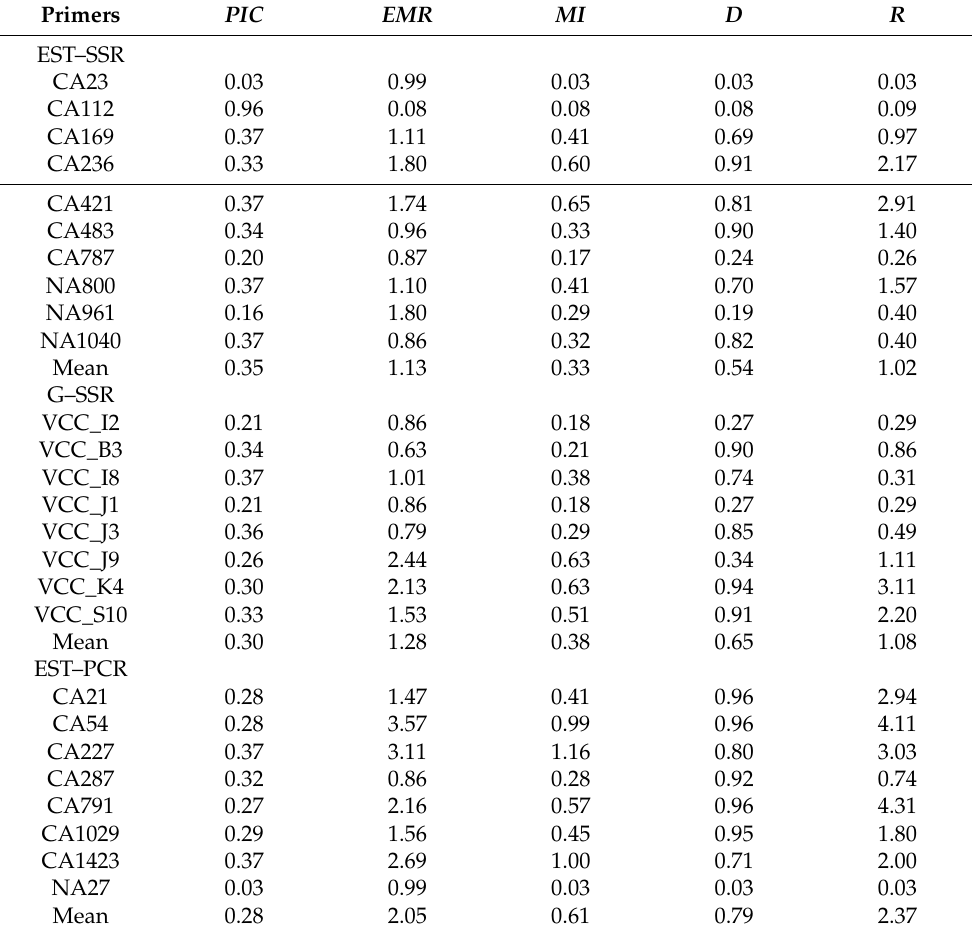
Table 4. Discriminatory power indices of EST–SSR, genomic (G)–SSR and EST–PCR markers for diversity analysis of blueberry hybrids, wild clones and